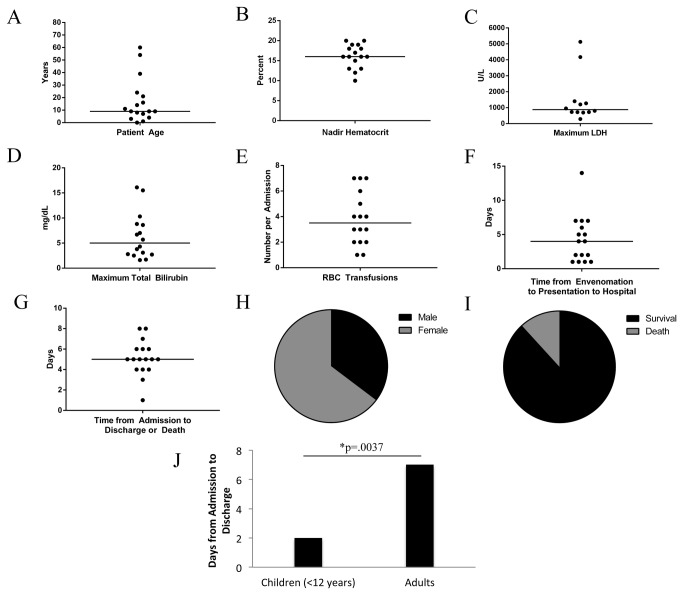
Characteristics of victims of severe Brown Recluse spider bite mediated hemolysis from 2002 through 2012 at Vanderbilt University Medical Center.Horizontal line identifies the median value.